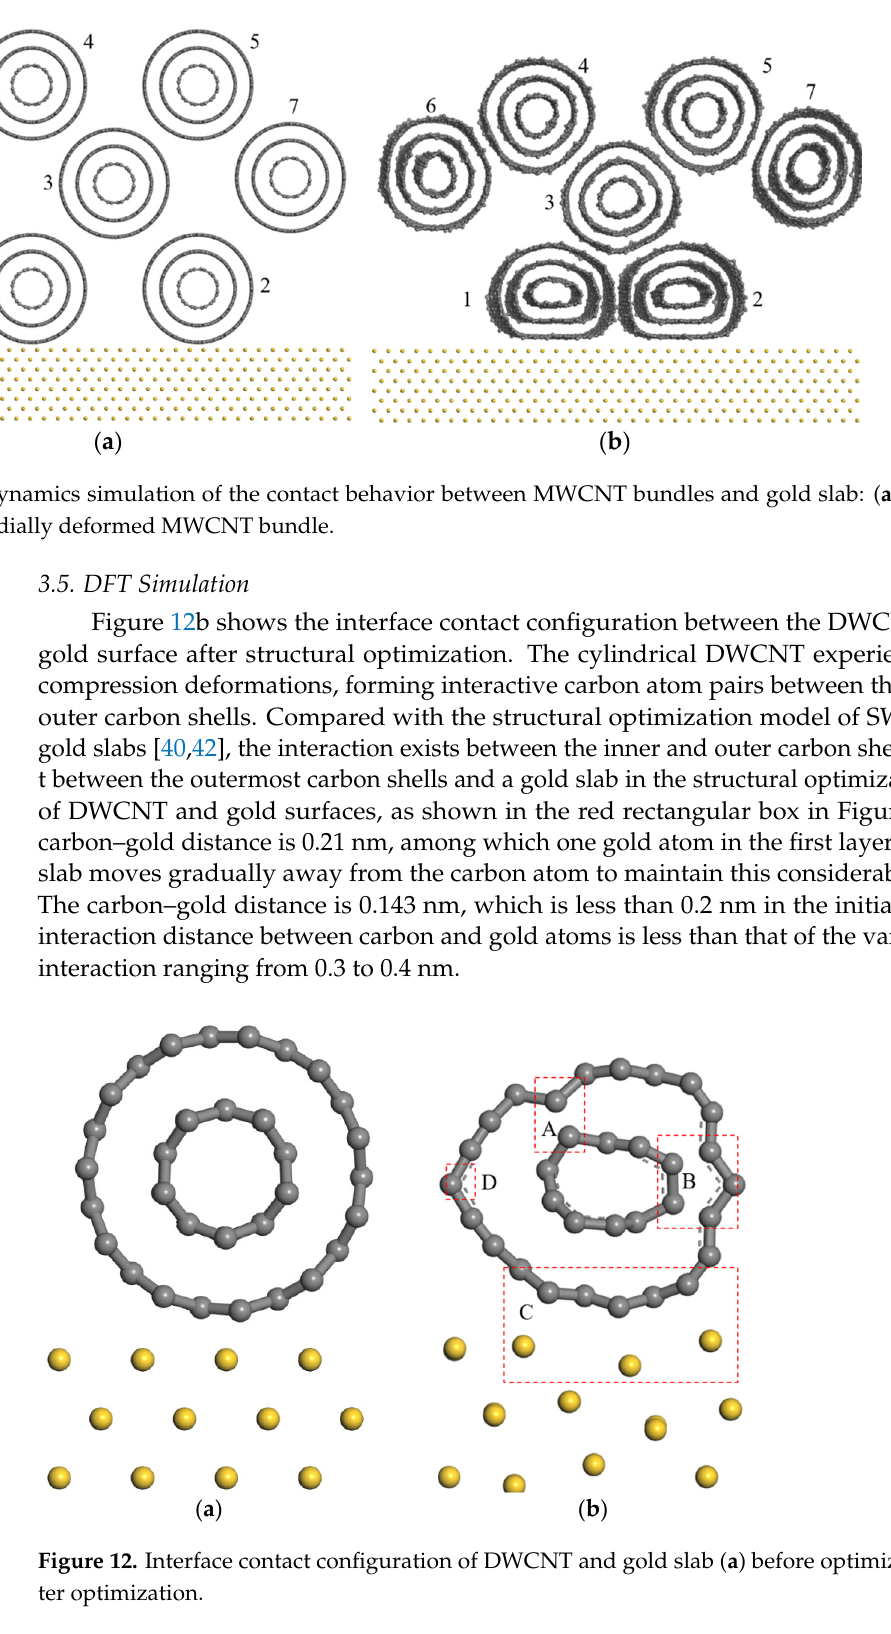
( c ) Figure 13. Electrostatic potential at the interface of DWCNT contacting with gold. ( a ) region A; ( b ) region B; ( c ) region C. The charge density difference between carbon and gold atoms can contribute to an understanding of the electron transport mechanism at the interface between MWCNTs and metal electrodes. The charge density difference can be computed as follows: the charge density of the whole system minus the sum of the charge densities of the metal surface and SWCNTs calculated as an isolated system in the geometry position of the op- timized whole system. From a slice of the charge density difference, a positive differential charge density indicates electron enrichment. Conversely, a positive differential charge density shows where the density has been depleted. Figure 14 displays a 2D slice showing